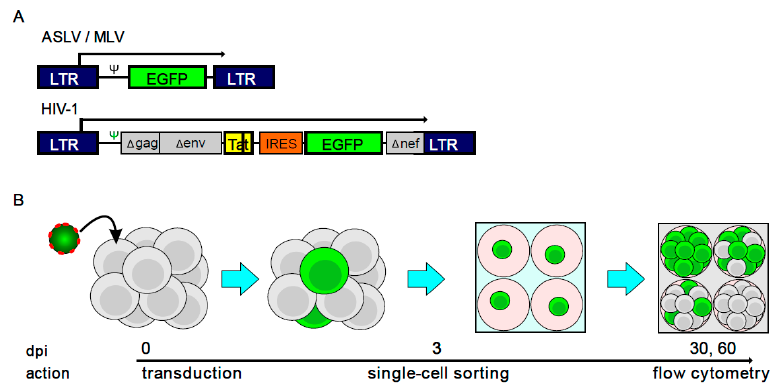
Figure 1. Vectors and the methodological approach used in this study to isolate single-cell clones with stable active proviruses. ( A ) Schematic representation of retroviral vectors. Avian sarcoma/leukosis virus (ASLV)- and murine leukaemia virus (MLV)-based vectors are of the same structure containing just the respective long terminal repeats (LTR) and enhanced green fluorescent protein (EGFP) for proviral activity detection. The human immunodeficiency virus (HIV)-based vector contains deleted fragments of gag, env and nef genes, full-length tat and EGFP genes and internal ribosomal entry site (IRES). Transcription start sites (TSS) are denoted by broken arrows. ψ , packaging signal. ( B ) The workflow in obtaining the single-cell clones. K562 cell line was transduced with low multiplicity of infection (MOI) of VSV-G-pseudotyped ASLV-, MLV- or HIV-based vectors. Three days post infection (dpi), Green fluorescent protein positive (GFP + ) cells were single-cell sorted to a 96-well plate and cellular clones were established. Cellular clones were examined for the percentage of GFP + cells 30 and 60 dpi by flow cytometry. Clones containing ≥ 90% of GFP + cells were subjected to further examination of proviral integration sites.